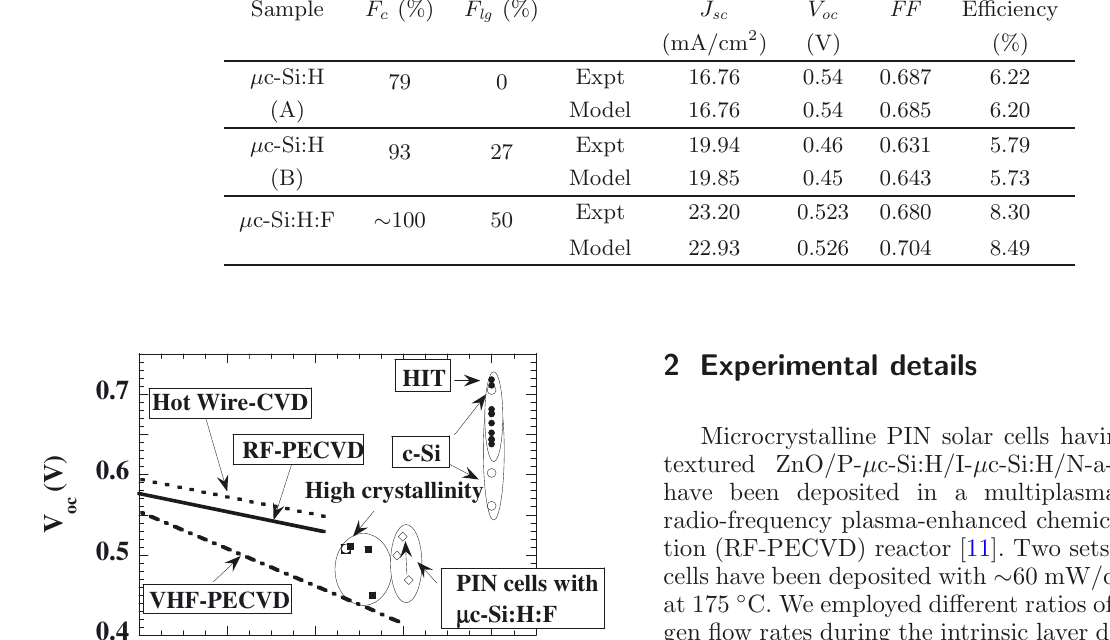
Table 1. Comparison between the measured and simulated solar cell output parameters of the PIN devices having low and intermediate crystalline volume fraction ( F c ) μ c-Si:H as the intrinsic layer. F lg gives the fraction of large grains in the I-layer. Also compared are the measured and modeled output parameters of the highly crystallized, large grained μ c-Si:H:F cell. Sample